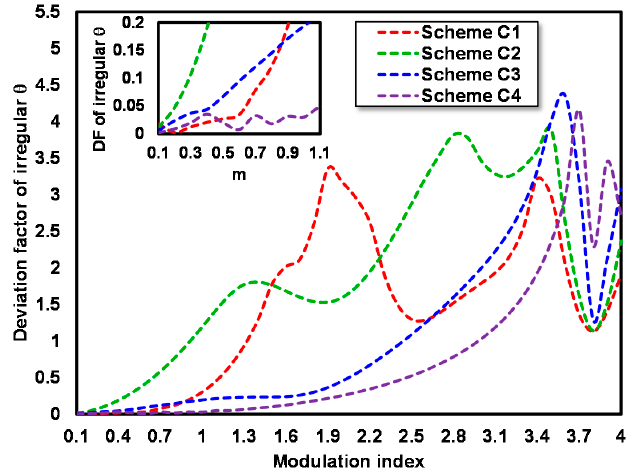
Figure 10. DF value for each irregular θ at 0.1 ≤ m ≤ 4 of schemes C1, C2, C3 and C4.